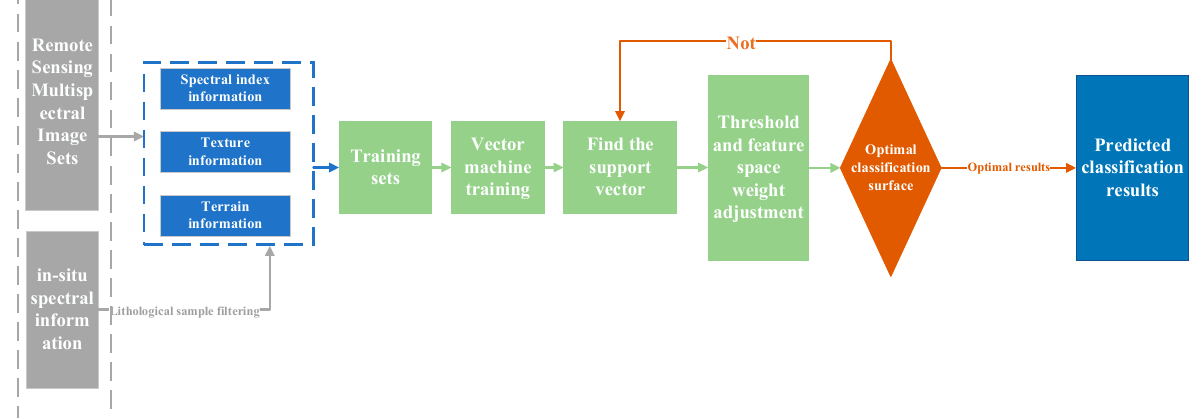
Figure 4. Support vector machine classification recognition process.